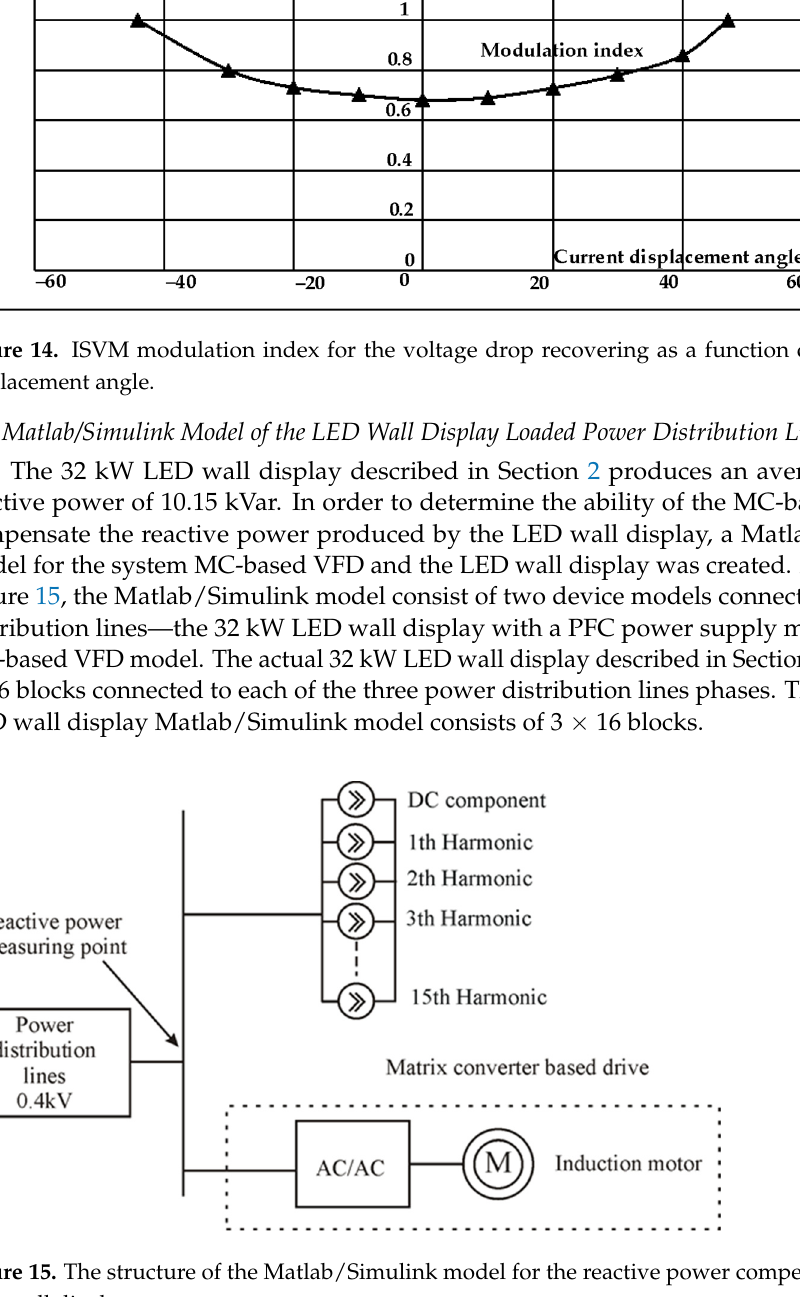
Figure 15. The structure of the Matlab/Simulink model for the reactive power compensation of the LED wall display.